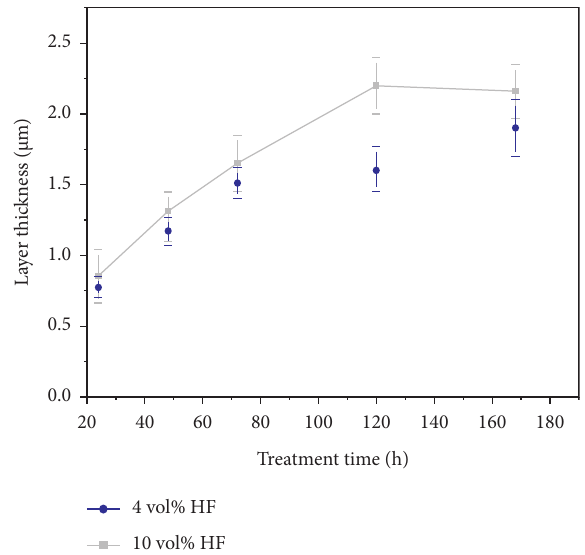
Figure 2: Variation of fluoride coating thickness on the AZ31 alloy as a function of treatment time